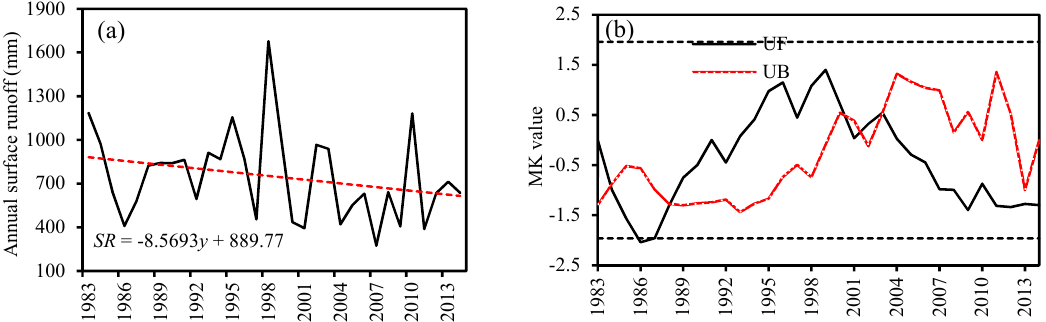
Figure 5. Inter-annual variation of observed surface runoff ( a ) and its MK results ( b ) in Pengchongjian small watershed in 1983–2014.